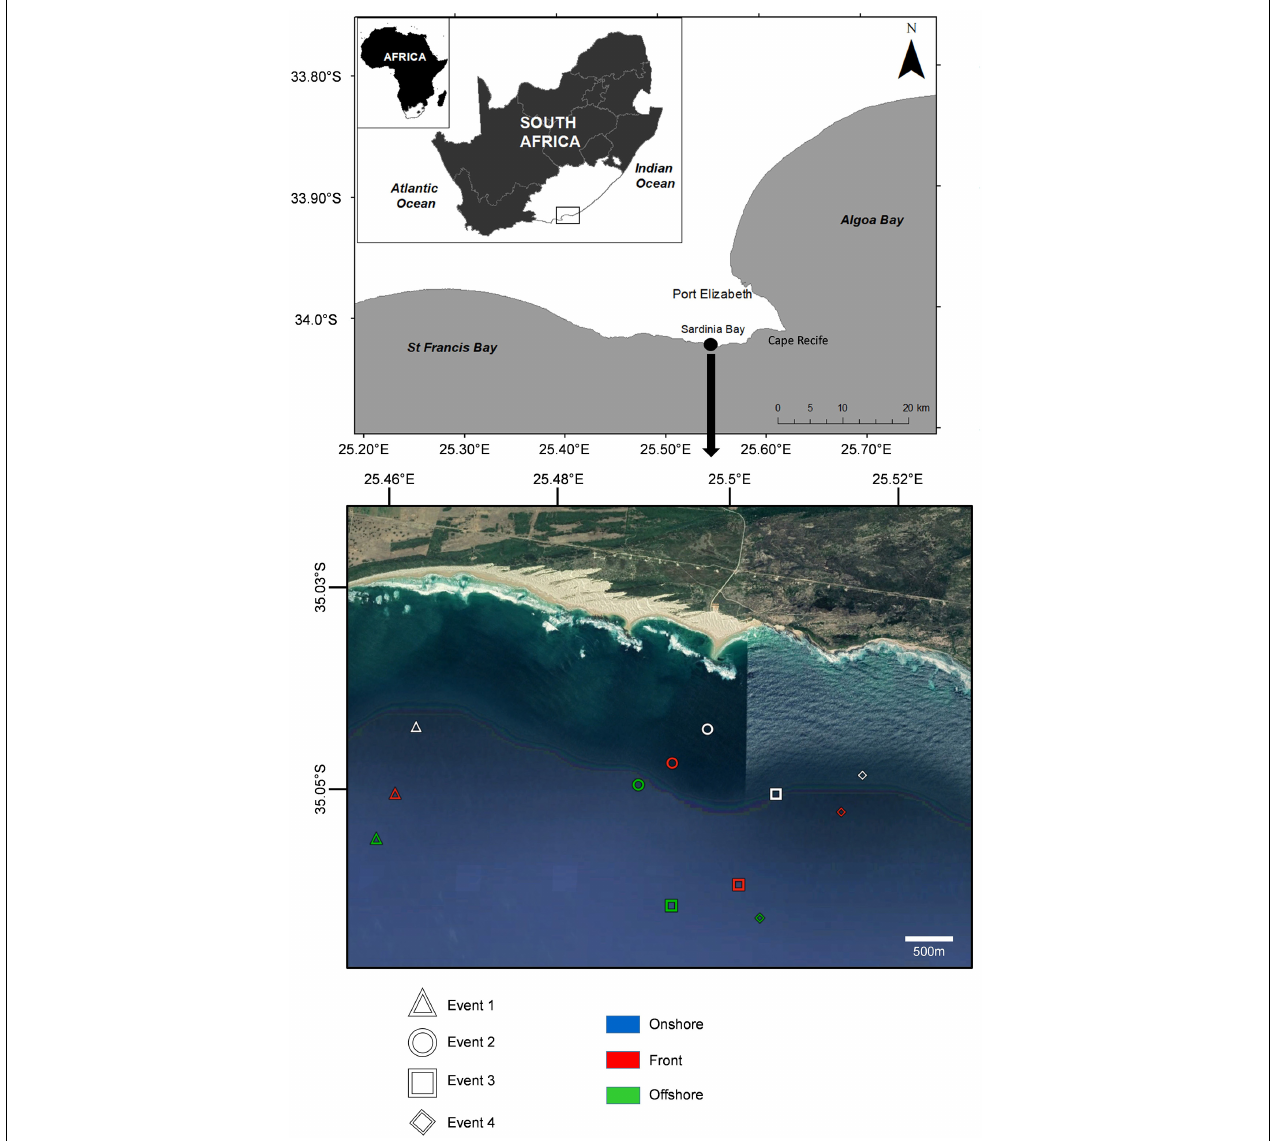
FIGURE 1 | Map of the study site, Sardinia Bay, in a high resolution Google Earth map, the nearshore location of the three sampling zones (onshore, front, and offshore) for each frontal event are shown.